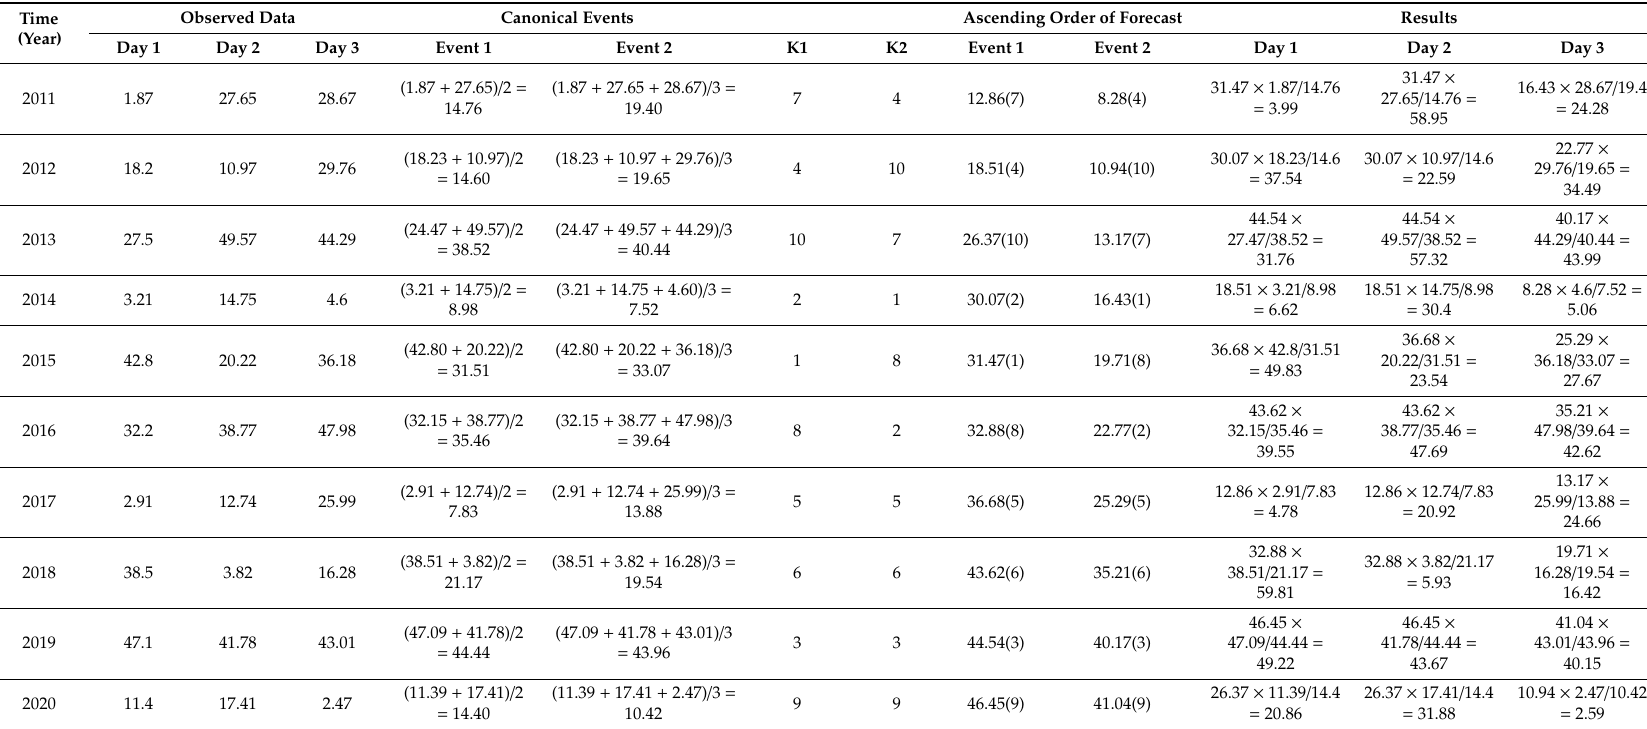
Table A1. An example for the handling process of canonical events by Schaake Shu ffl